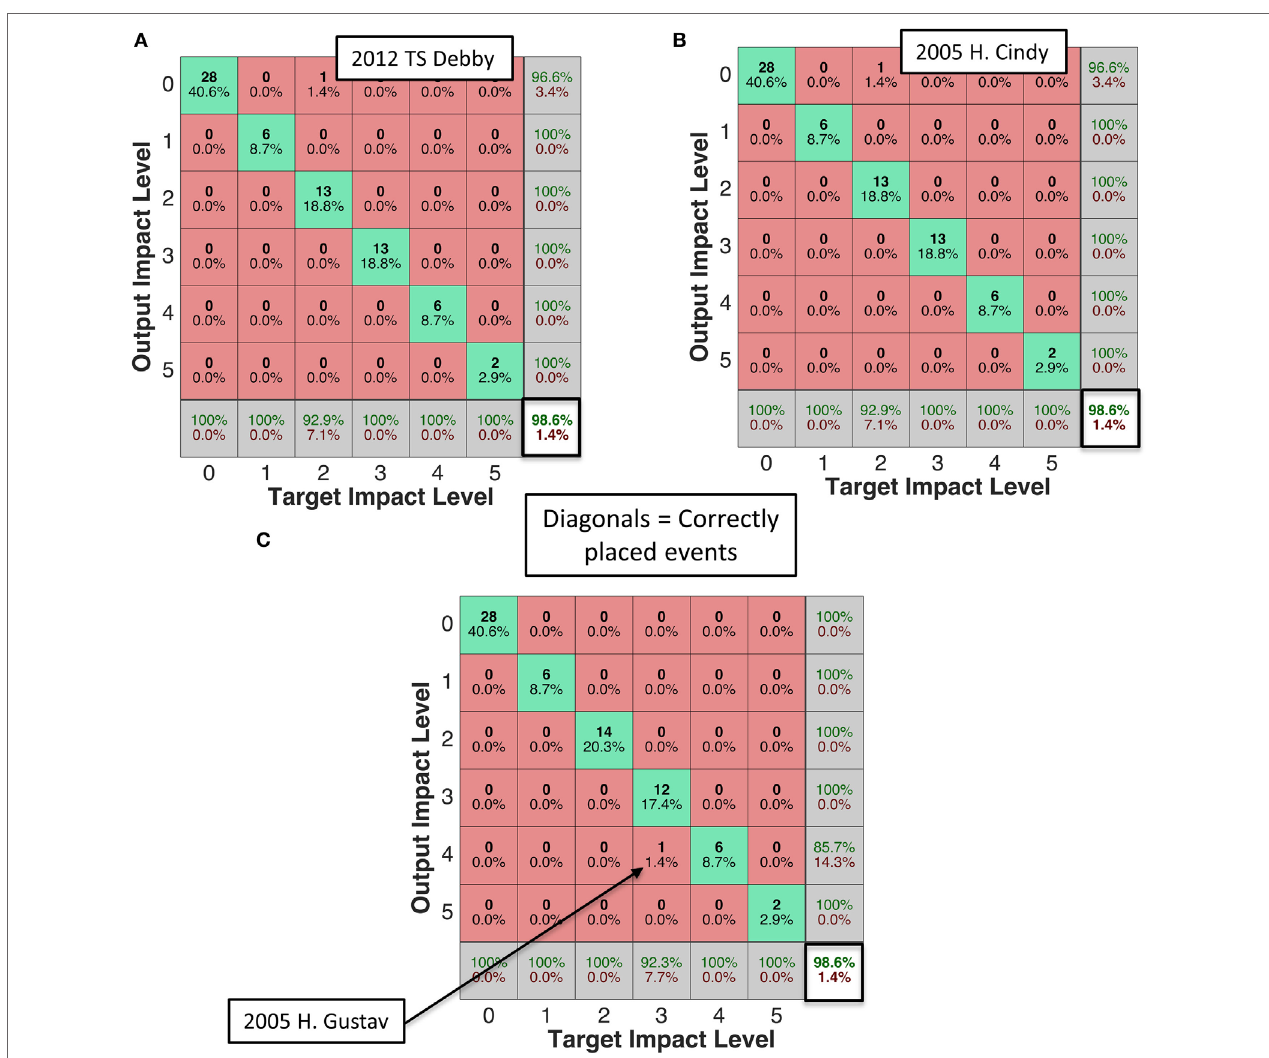
FigUre 3 | Storm event placement in building HIL Models (a) 2015e, (B) 2015f, and (c) 2015g (H = hurricane, TS = tropical